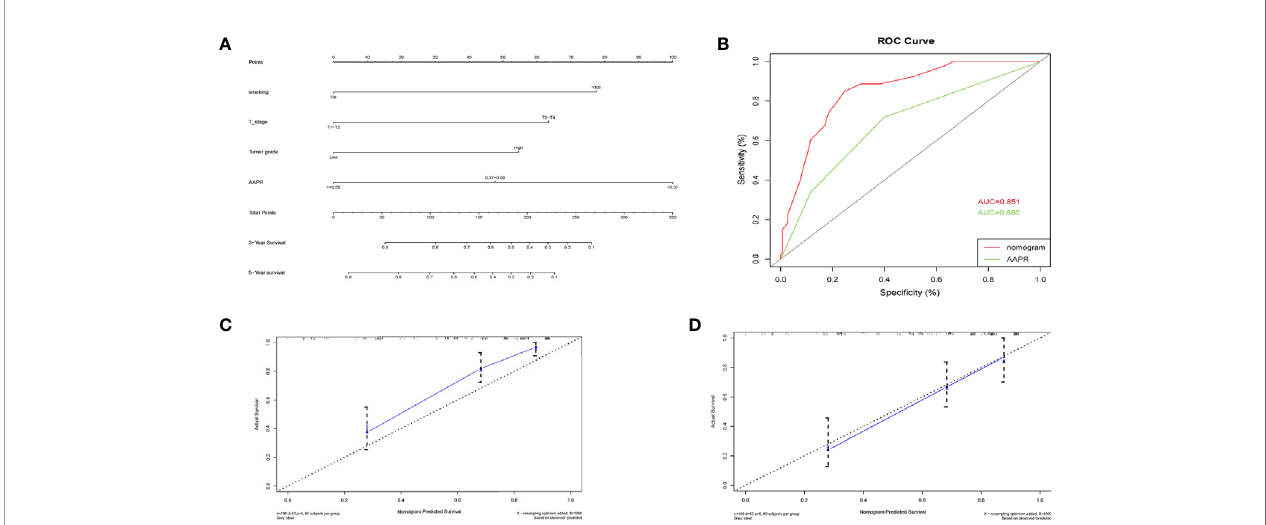
FIGURE 7 | Nomogram model constructed by independent prognostic factors predicting 3- and 5-year CSS for BC patients treated with RC (A) ; the ROC curve of AAPR and AAPR-based nomogram for predicting CSS in the primary cohort (B) ; corresponding calibration curves of nomogram model for 3- and 5- year CSS (C, D) . CSS, cancer-speci fi c survival; AAPR, albumin-to-alkaline phosphatase ratio; BC, bladder cancer; ROC, receiver operating characteristic; AUC, area under curve; CI, con fi dence interval.